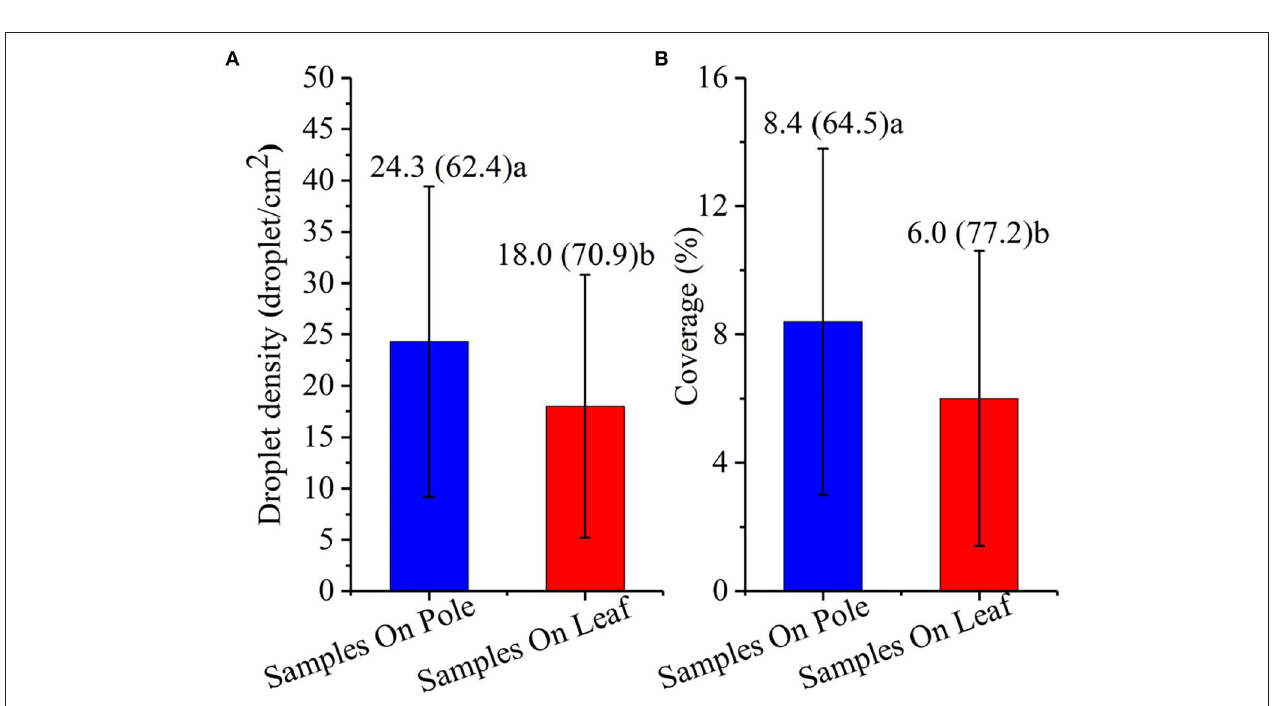
FIGURE 5 | Effects of sampling pole method and sampling leaf method on deposition characteristics of droplet density and coverage. (A) Droplet density and (B) coverage. The numbers in the figure are the mean value (CV), and the different lowercase letters after the numbers indicate the significant difference, p < 0.01.